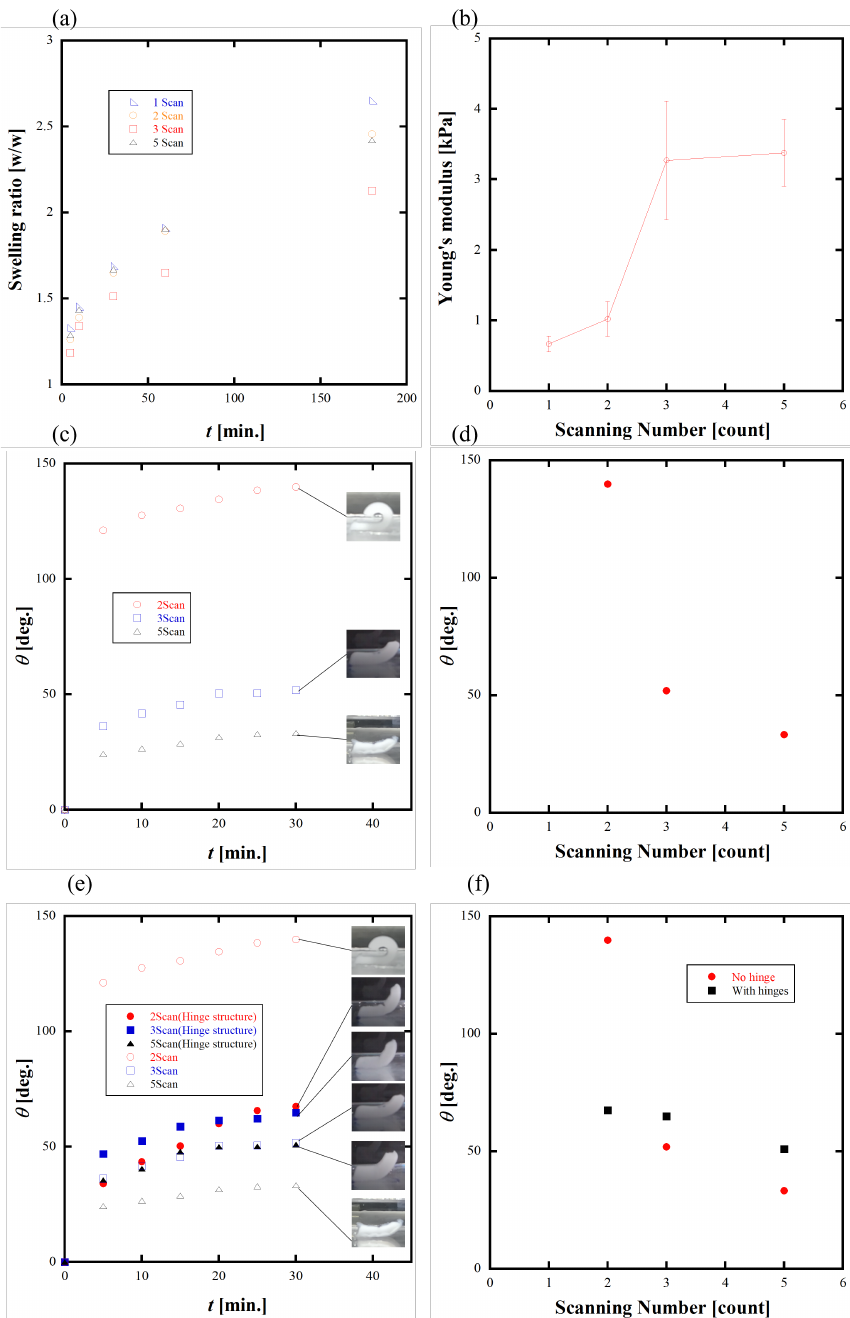
Figure 6. ( a ) The swelling ratio measurement as a function of time, in the one, two, three, and five scanning numbers of UV irradiation in 3D printing. ( b ) Young’s modulus measurement as a function of the scanning number of UV irradiation in 3D printing. ( c ) The bending angle as a function of time, in the various scanning numbers, without hinge structure. The inset photographs indicate the final states of deformation. ( d ) The bending angle as a function of the scanning number, without hinge structure. ( e ) The bending angle as a function of time, in the various scanning numbers, with/without hinge structure. The inset photographs indicate the final states of deformation. ( f ) The bending angle as a function of the scanning number, with/without hinge